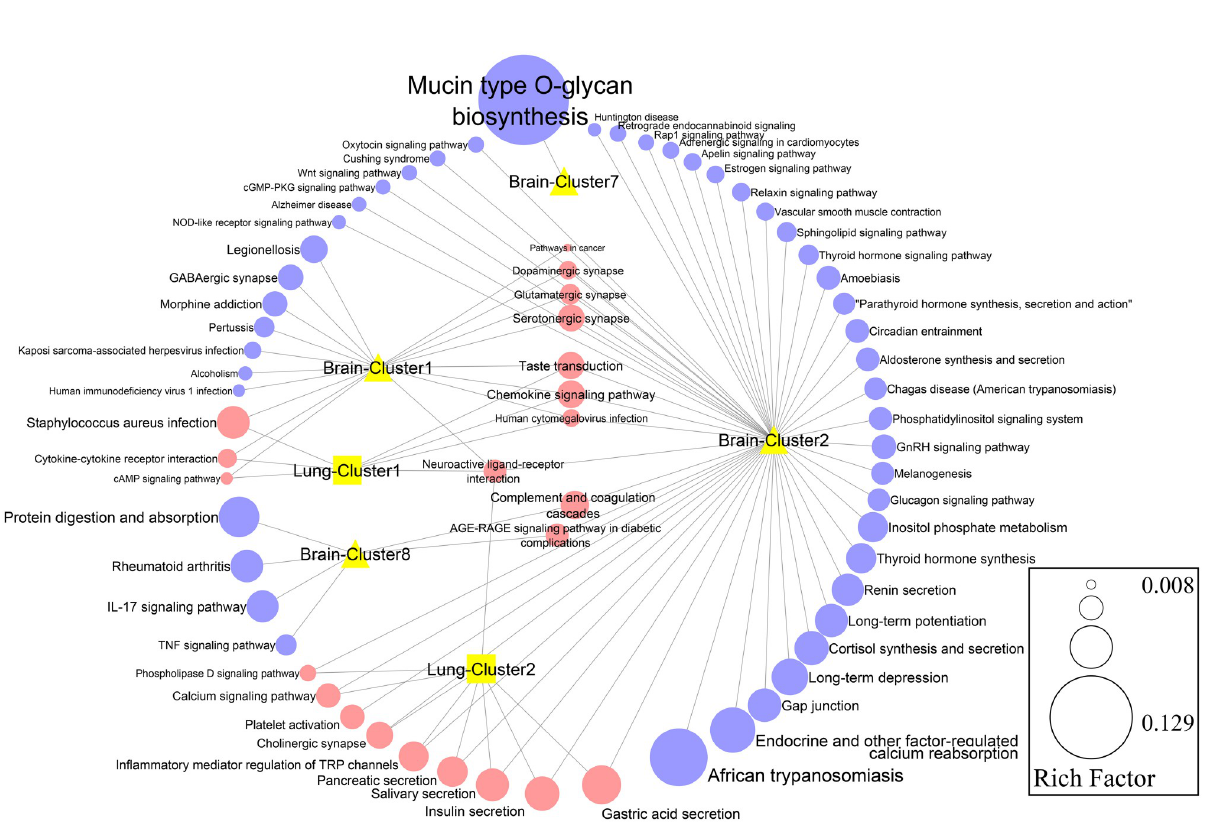
Fig 6. Kyoto Encyclopedia of Genes and Genomes (KEGG) enrichment analysis for all function clusters of the brain and lung metastases network. The size of the circles represents the number of genes enriched in each pathway. The adjusted P-value � 0.05 was set as the cutoff.